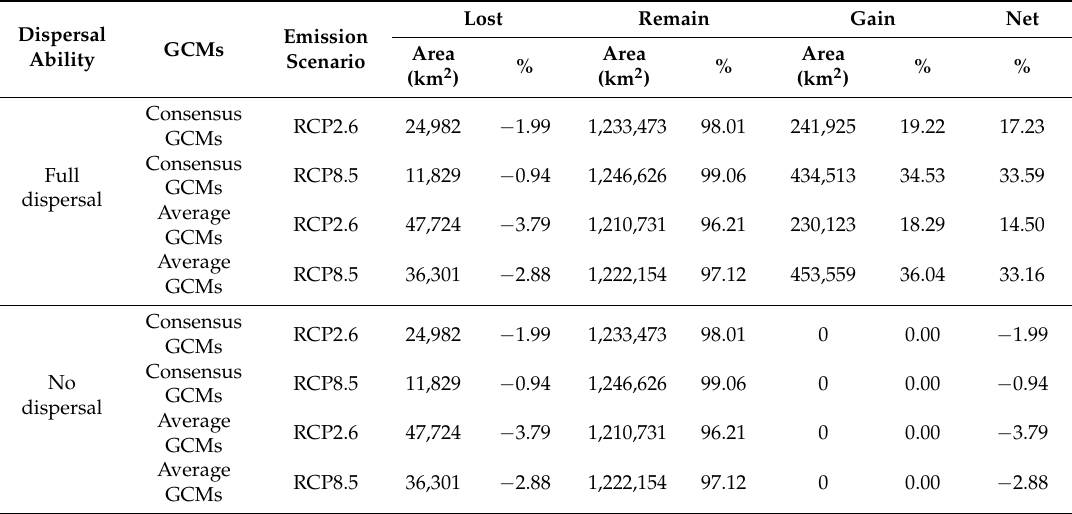
Table 2. Predicted range shifts of suitable habitats in 2050s (2041–2060) relative to the current potential distribution (1950–2000) for Sapindus mukorossi in